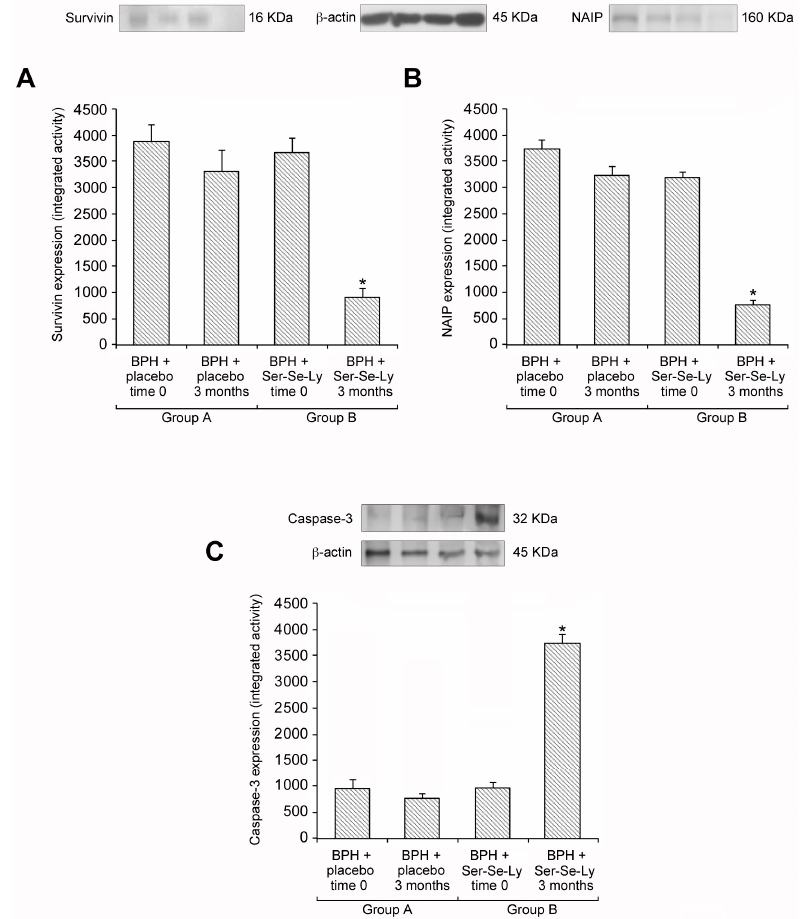
Figure 1. Representative Western Blot analysis of survivin ( A ); neuronal apoptosis inhibitory protein (NAIP) ( B ); and caspase-3 ( C ) expression in the prostate from benign prostatic hyperplasia (BPH) patients at time 0 and at 3 months; and from Ser-Se-Ly treated BPH patients at time 0 and at 3 months. * p < 0.05 vs. BPH patients at time 0 and at 3 months, and Ser-Se-Ly treated BPH patients at time 0. Bars represent the mean ± SE of 90 patients.